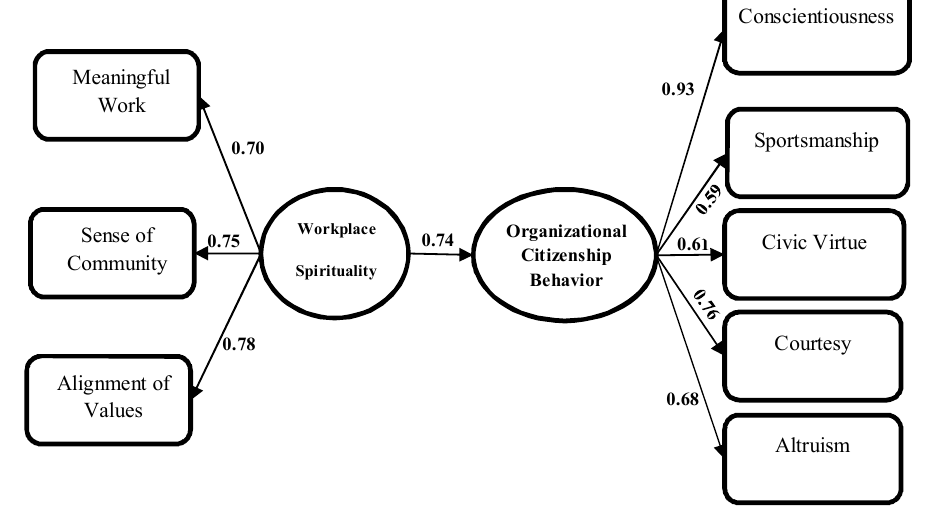
Fig. 1. The structural equation model of workplace spirituality and Organizational Citizenship behavior using the LISREL